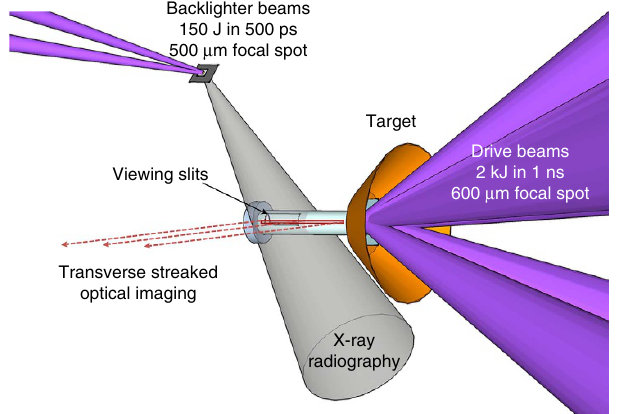
Figure 1 | Schematic of the experimental set-up. The laser beams from the Orion facility are arranged in two cones, which we refer to as ‘drive’ and ‘backlighter’. The drive cone consisted of five beams, which illuminated the target in a 100 (cid:2) cone angle, with each beam supplying B 400J (2kJ in total) in 1ns onto a 600- m m spot, which gave an average intensity of 7.0 (cid:3) 10 14 Wcm (cid:2) 2 . For the backlighter cone, we used two laser beams of total energy 150J, in 500ps onto a 500- m m spot, which gave an average intensity of 1.5 (cid:3) 10 14 Wcm (cid:2) 2 . Both sets of beams were delivered at the third harmonic with a wavelength of 351nm. Viewing slits, along the X-ray diagnostic line of sight, were cut on either side of the tube at the obstacle